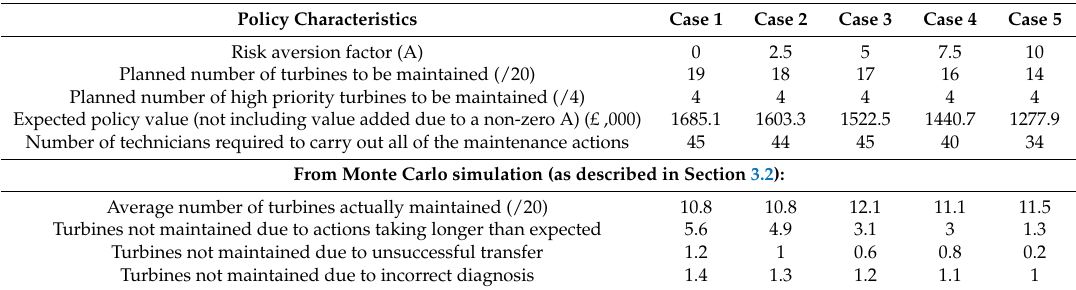
Table 1. Comparison of cases including Monte Carlo simulation